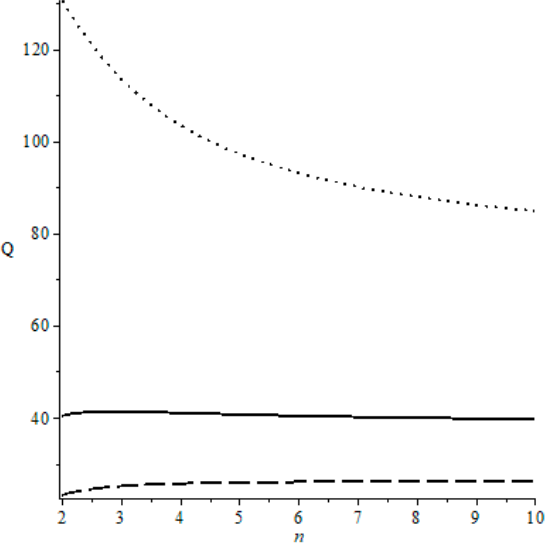
Figure 4. To calibrate Figure 4, we used log-linear utility function, a Cobb–Douglas production function, and the following parameter values: q = 0.8, A = 20, β = 0.09, and α = 0.55 (dotted line); α = 0.3 (dashed line); and α = 0.4 (solid